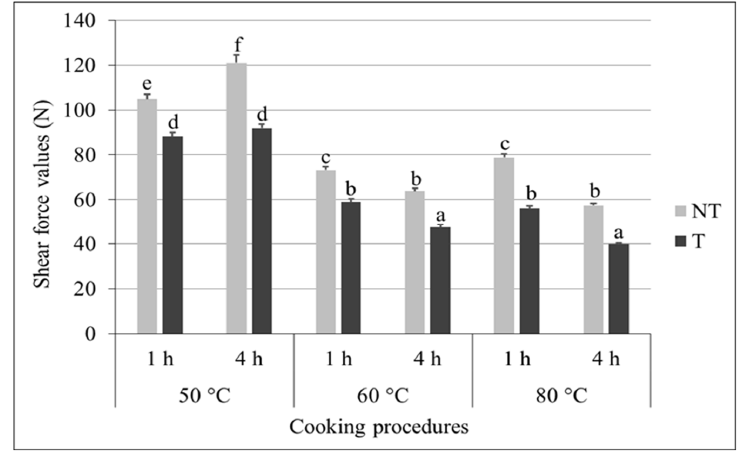
Figure 3. Shear force (SF) values measured on bovine Semitendinosus muscle samples previously tumbled (T) or not (NT, used as control) and then sous-vide cooked at 50 °C, 60 °C or 80 °C for 1 h or 4 h. The data correspond to mean values ± standard error (SE) calculated from 90 individual samples prepared from three different ST muscles. Different letters (a–f) refer to significant differences between all treatments. Table 1. Statistical analysis of the simple effects of the factors (tumbling process (Treat), cooking temperature (Temp), and cooking time (Time)) and their cross-effects (Treat × Temp, Treat × Time, and Temp × Time) on values of shear forces (SF), cooking losses (CL), total water content (TWC), lightness (L*), redness (a*), yellowness (b*), chroma (C*), and hue angle (H*) evaluated on sous-vide cooked bovine Semitendinosus muscle samples. NS = not significant, * p < 0.05, ** p < 0.01, *** p < 0.001.